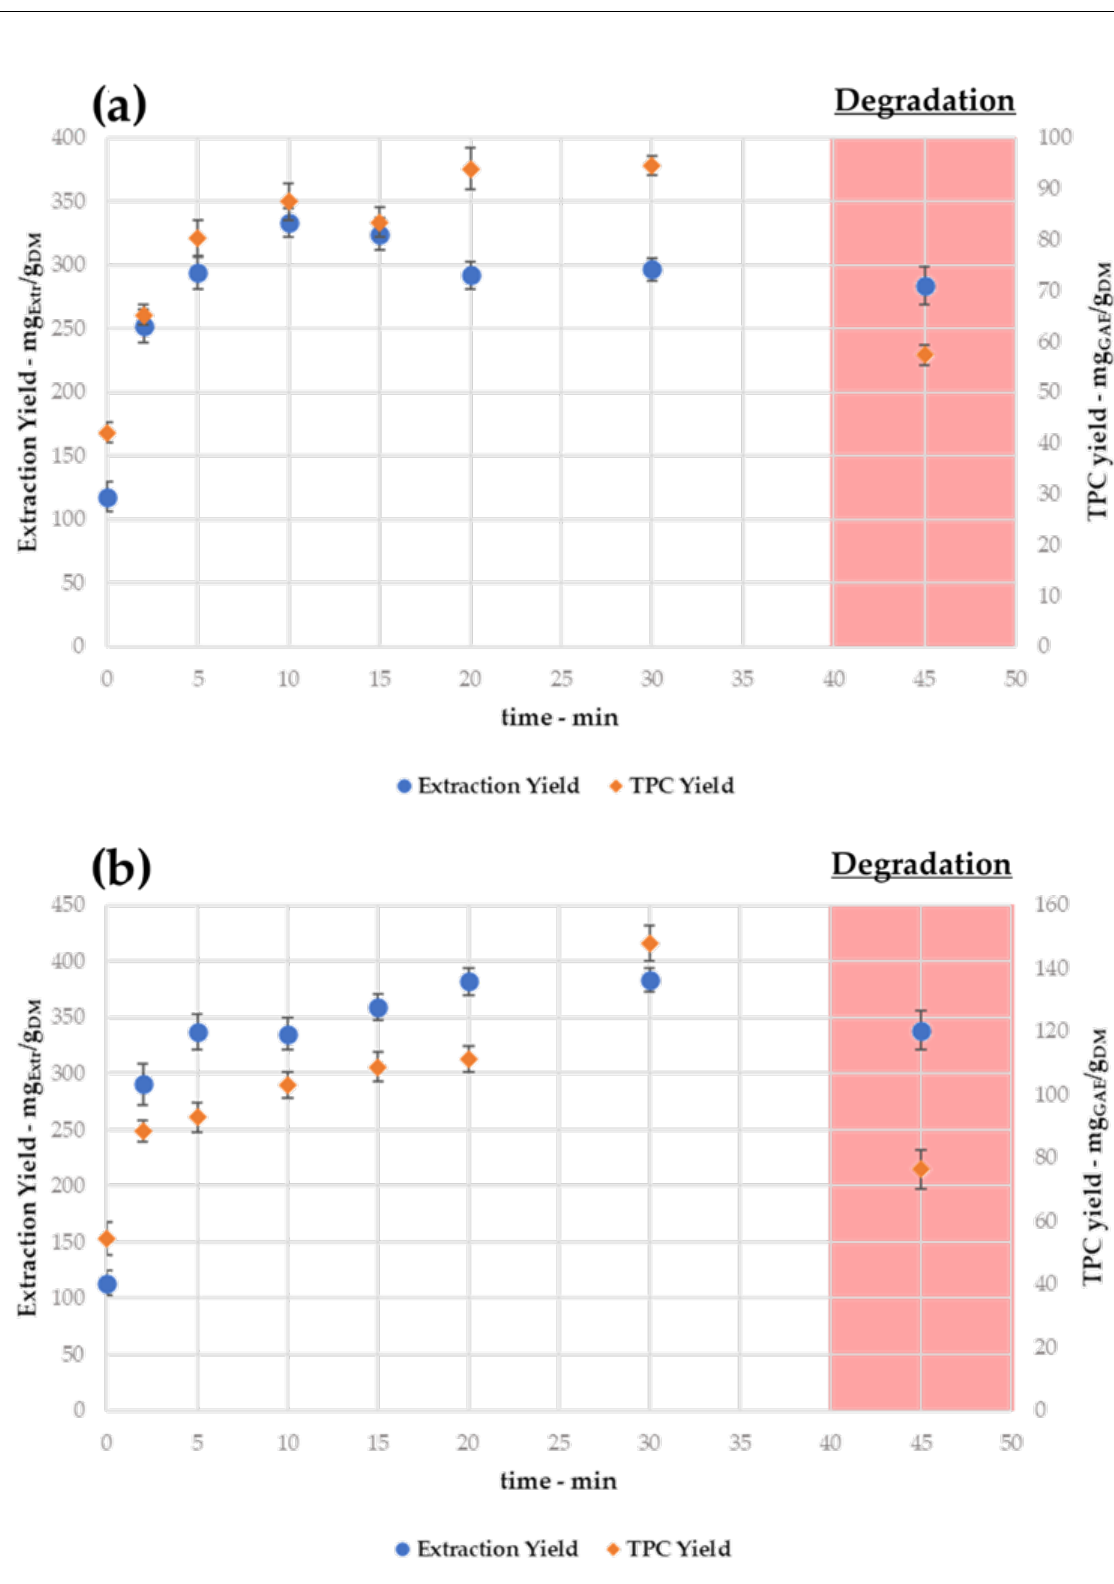
Figure 4. SWE kinetics at 150 °C for different S/L ratios. ( a ) 1:20; ( b ) 1:30.